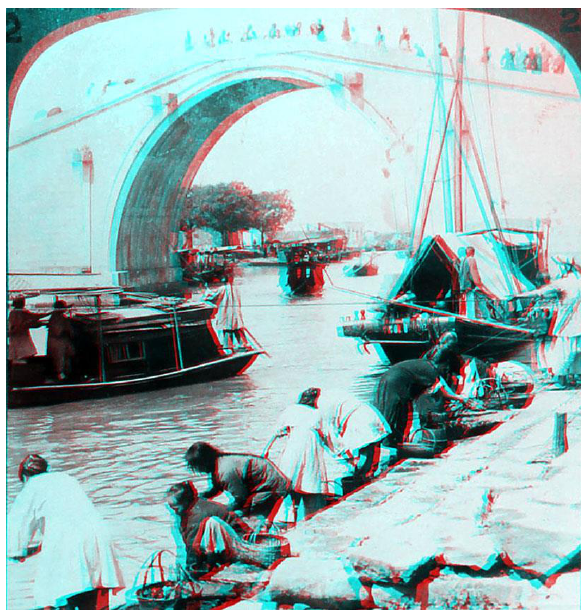
Figure 3. Anaglyphs presentation of figure 2, showing partly